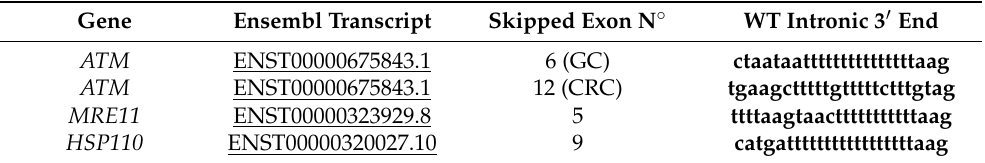
Table 1. Intronic PPT in ATM , MRE11 and HSP110 genes. The intronic splice acceptor site ( ag ) is preceded by the PPT. GC: gastric cancer, CRC: colorectal cancer. WT: Wild